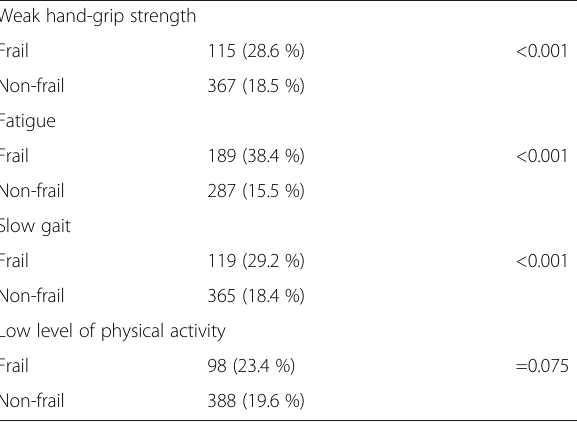
Table 2 Sample description according to prevalence of depressive symptoms ( n = 2402). FIBRA Unicamp,